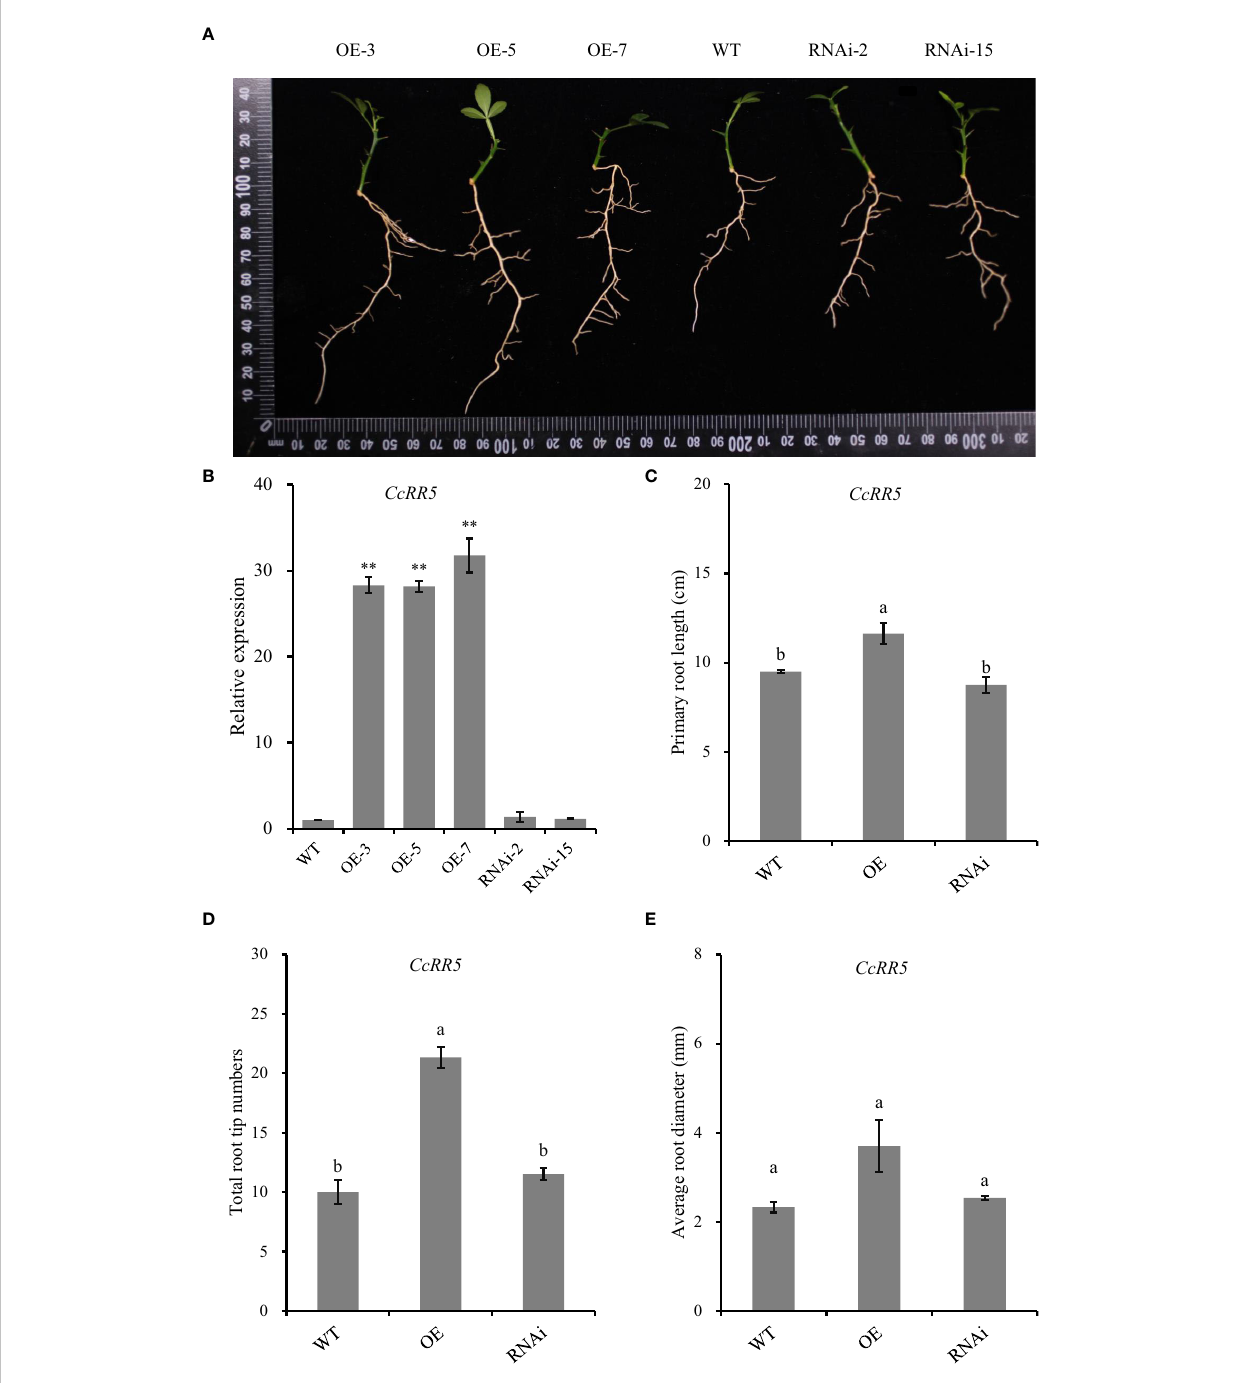
FIGURE 7 Functional analysis of CcRR5 in citrus. (A) Morphological observations of roots in CcRR5 overexpression (CcRR5-OE) and CcRR5 RNA interference (CcRR5-RNAi) transgenic plants. (B) Relative expression of CcRR5 in transgenic plants, (C) primary root length of plantlet, (D) total root tip numbers of plantlet, and (E) average root diameter of plantlet. The error bars in (B) indicated the mean ± SD ( n = 3). The asterisk indicated that the expression of CcRR5 in overexpression and silence plants was signi fi cantly different with that in the WT plants. ** p < 0.01. The error bars in (C – E) indicated the mean ± SE. Means followed by different letters (a, b) indicate signi fi cantly different at p <